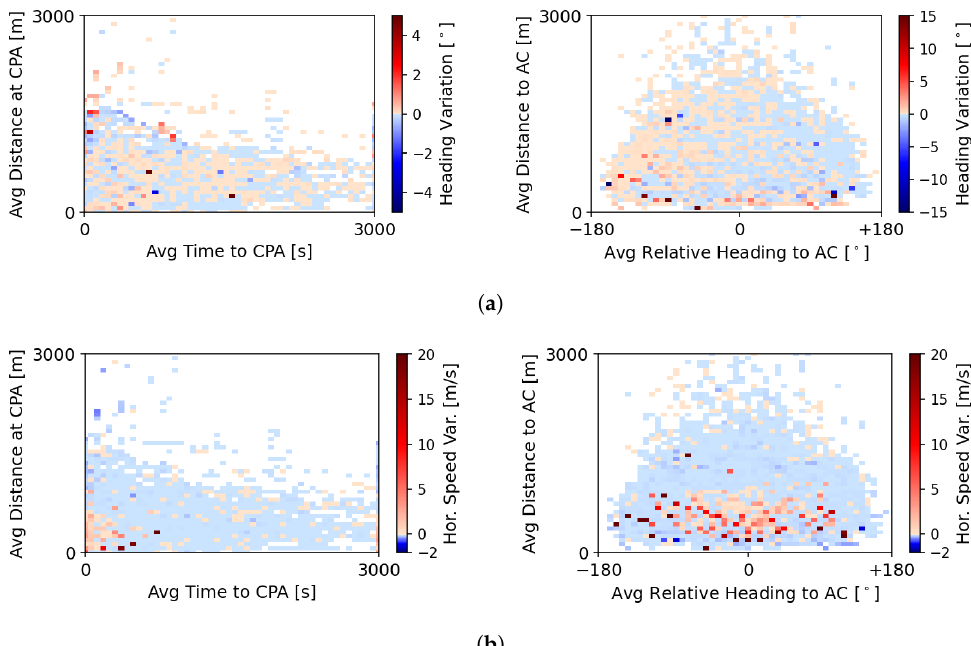
Figure 6. State variation output by the hybrid RL + MVP method for conflict resolution in the training scenarios. ( a ) Heading variation performed by the hybrid RL + MVP method. ( b ) Horizontal speed variation performed by the hybrid RL + MVP